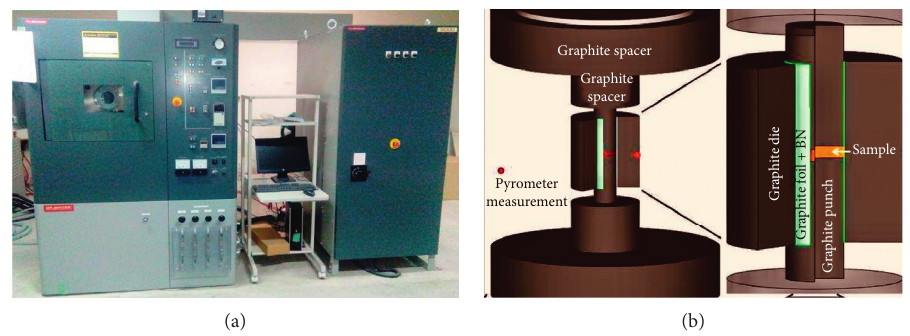
Figure 3: (a) Spark plasma sintering machine. (b) Spark plasma sintering